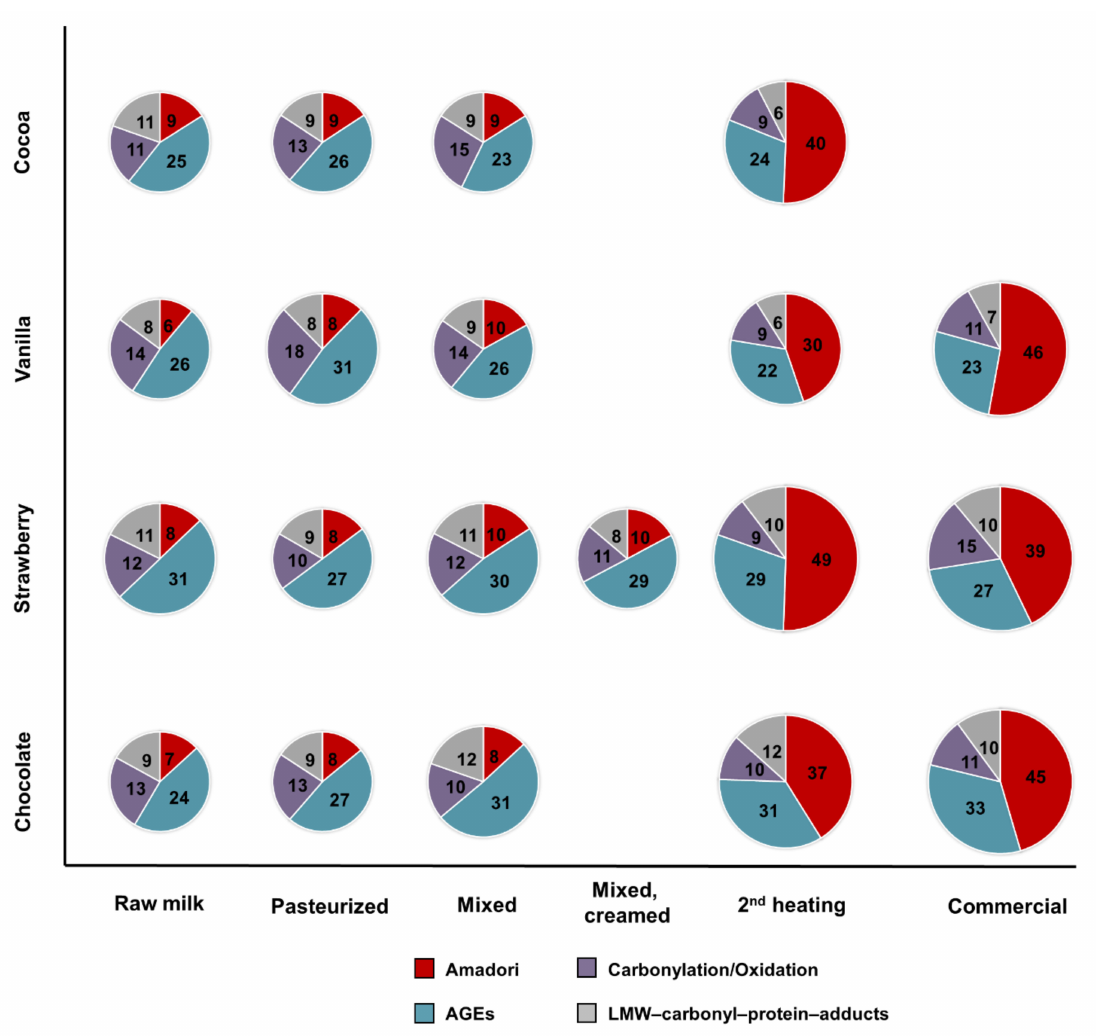
Figure 4. Contribution of each modification type to the overall number of identified modified peptides for the cocoa-, vanilla-, strawberry-, and chocolate-flavored milk drinks at each step of the processing chain. Samples included raw milk, pasteurized milk, milk mixed with flavorings, milk drink after the second heat treatment, and the commercial products. The size of the pie diagrams indicates the overall number of